Question: Which visualization type does this figure use?
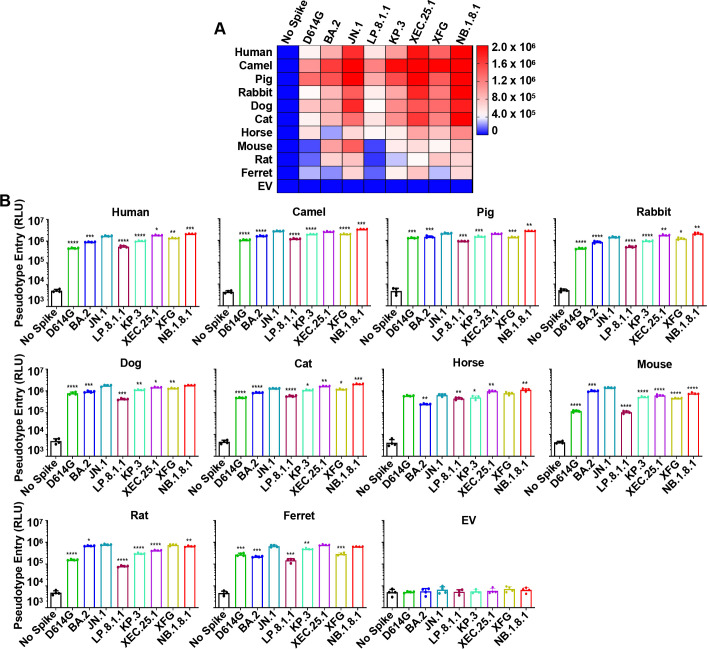
Answer: heatmap